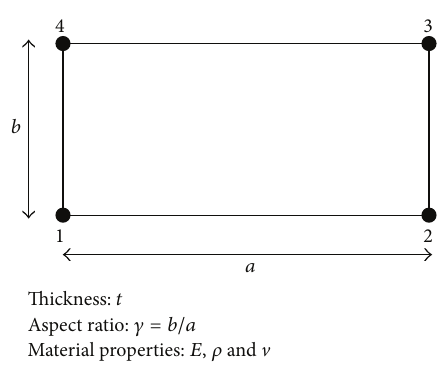
Figure 3: Rectangular Finite Element (Plane-Stress